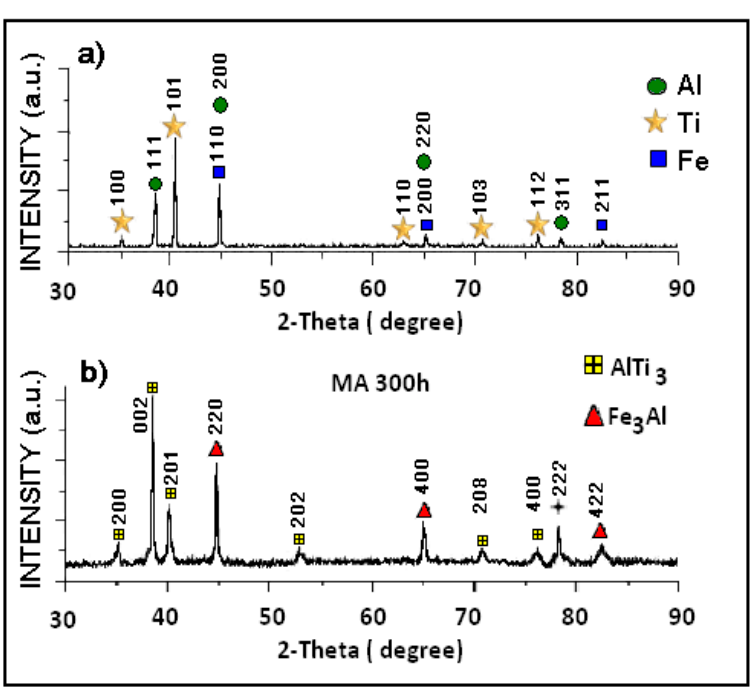
Figure 1. X-ray di ff raction (XRD) patterns of ( a ) the mixture of Al, Ti and Fe powders and ( b ) after milled for 300 h. Table 1. Crystallographic data of the initial powders.